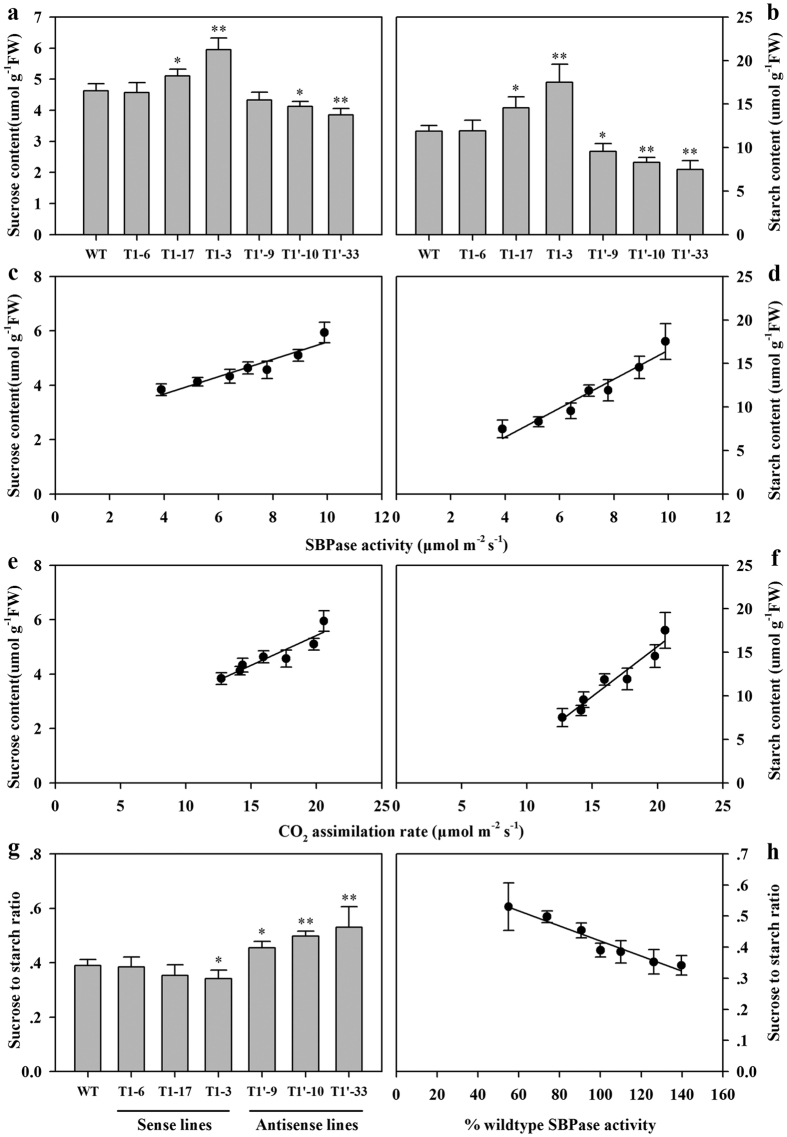
Carbohydrate content in fully expanded leaves of SBPase sense and antisense tomato plants.All measurements were done on 12-leaf wild-type and T1 progeny of transgenic tomato plants. (a,b) Contents of sucrose and starch were determined in fully expanded leaves (leaf no. 8, 9 from base) harvested at the end of day. (c) Sucrose level as a function of SBPase activity. (d) Starch content as a function of SBPase activity. (e) Sucrose content as a function of CO2 assimilation rate. (f) Starch content as a function of CO2 assimilation rate. (g) Sucrose-to-starch ratios in SBPase sense and antisense tomato plants. The results are the means ± SDs (n = 6). Asterisks indicate significant differences between WT and transgenic plants (* for P < 0.05; ** for P < 0.01).